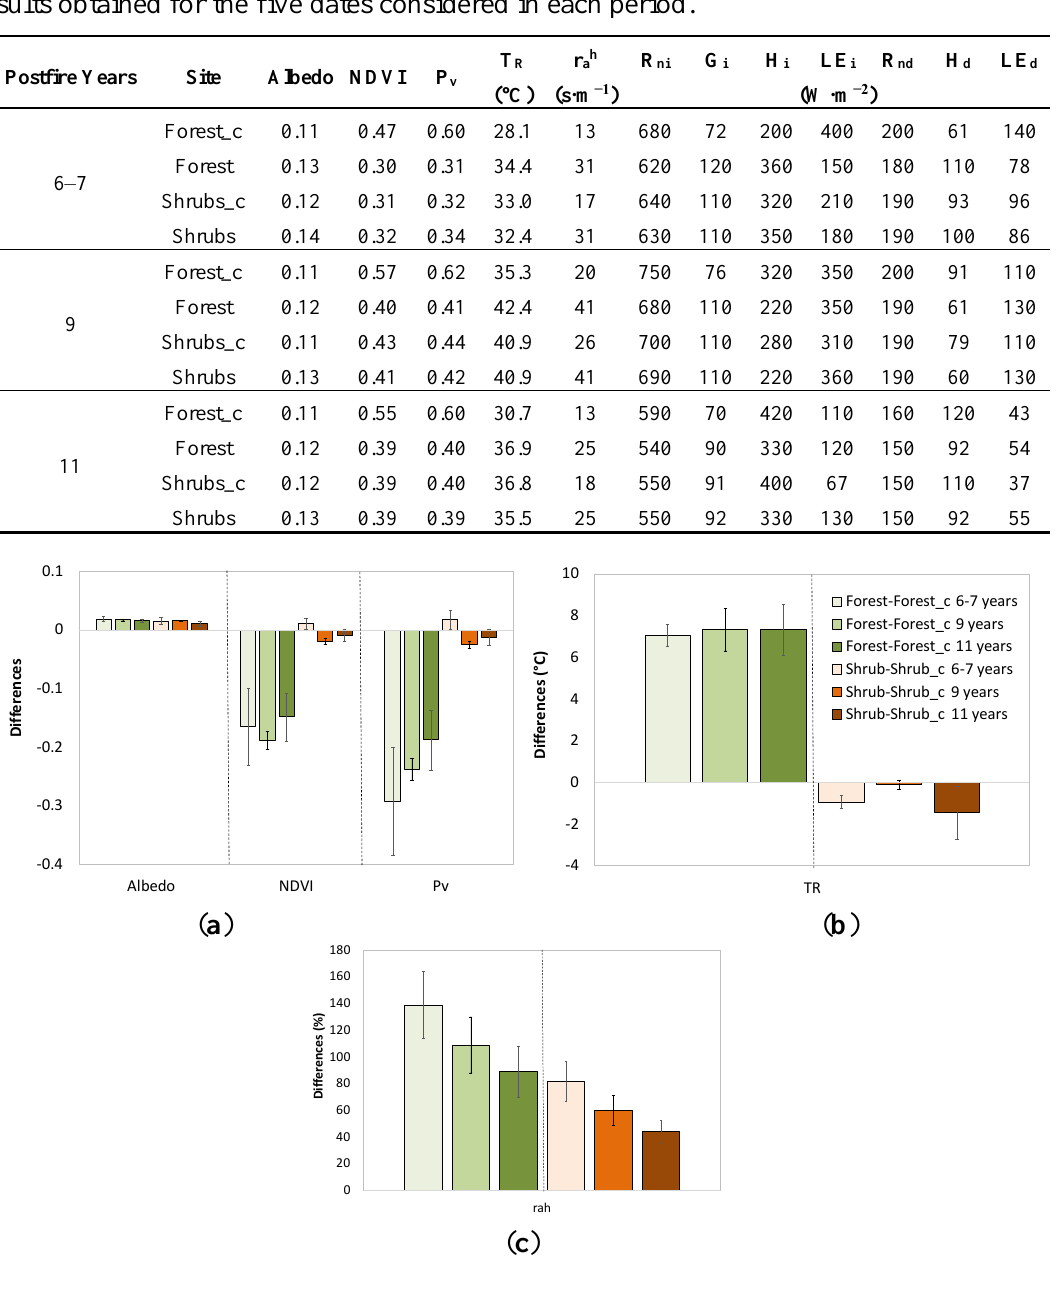
Figure 5. Average values of the differences between burnt and unburnt (control_c) areas in terms of the main surface parameters: ( a ) albedo, NDVI, P v , ( b ) T R , and (c) r ah , for all study sites and dates. Error bars represent the standard deviations of the